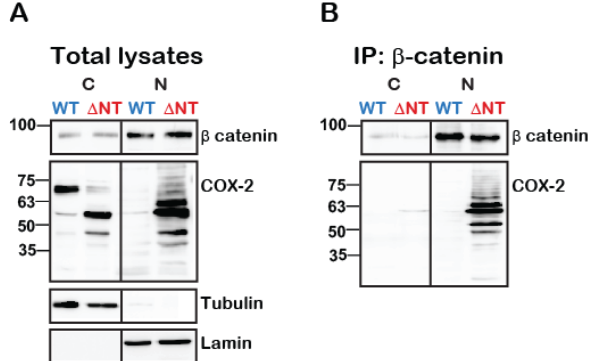
Figure 6. Truncated COX-2 interacts with β-catenin in the nucleus. HEK 293 cells with endogenous expression of β-catenin were transfected with either WT or ΔNT- COX-2 for 18 h. On the following day, cells were lysed, fractionated into cytosolic and nuclear fractions protein was determined and equal protein amounts underwent immunoprecipitation with anti-β catenin for 24 h at 4 °C. Cytosolic (C) and nuclear (N) fractions are confirmed by tubulin and lamin staining, respectively. ( A ) Total lysate separation shows that WT and ΔNT- COX-2 are equally expressed as is endogenously expressed β-catenin. ( B ) COX-2 is only present in the nucleic fractions of ΔNT but not WT COX-2 ( n = 3 independent experiments).